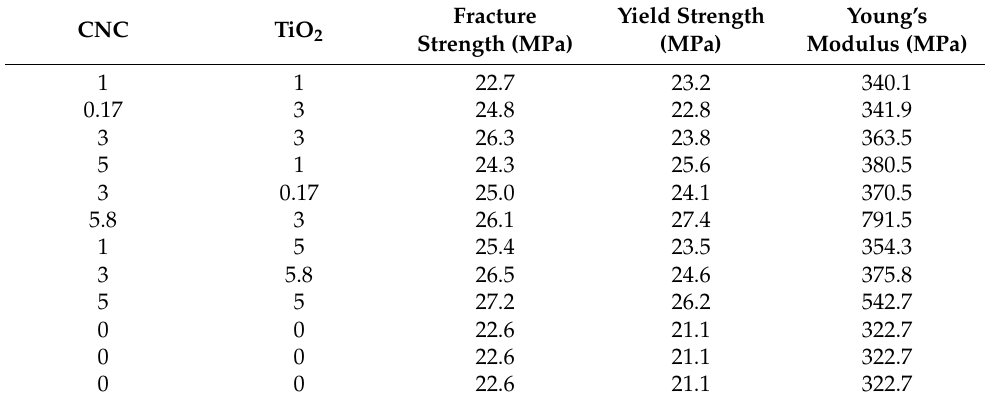
Figure 13. Regression plots for Young’s modulus modeled of the developed nanobiocomposites by ANN (( a ): training, ( b ): validation, ( c ): testing, ( d ): average). Table 7. Summarized predicted mechanical properties of the HDPE nanobiocomposites by